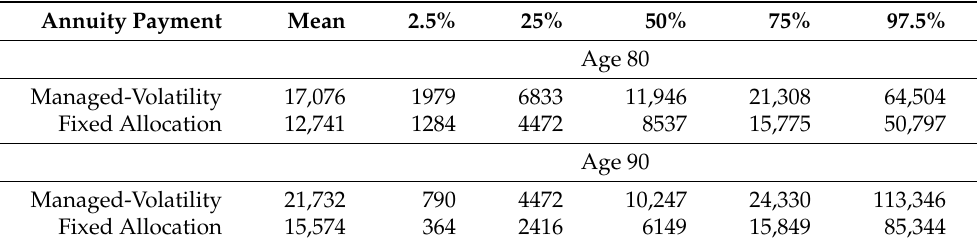
Table 3. Base Case: Annuity Payments at Age 80 and 90—Nominal.